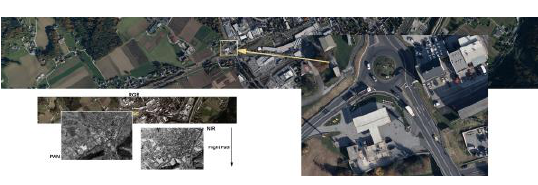
Fig. 4: Results of an UltraCam Condor photo mission at 2200 m AGL and 10 cm GSD. The crop area on the right shows a 130 m by 100 m portion of the RGB image. The footprint for PAN, RGB and NIR is illustrated at the lower left part of this figure.